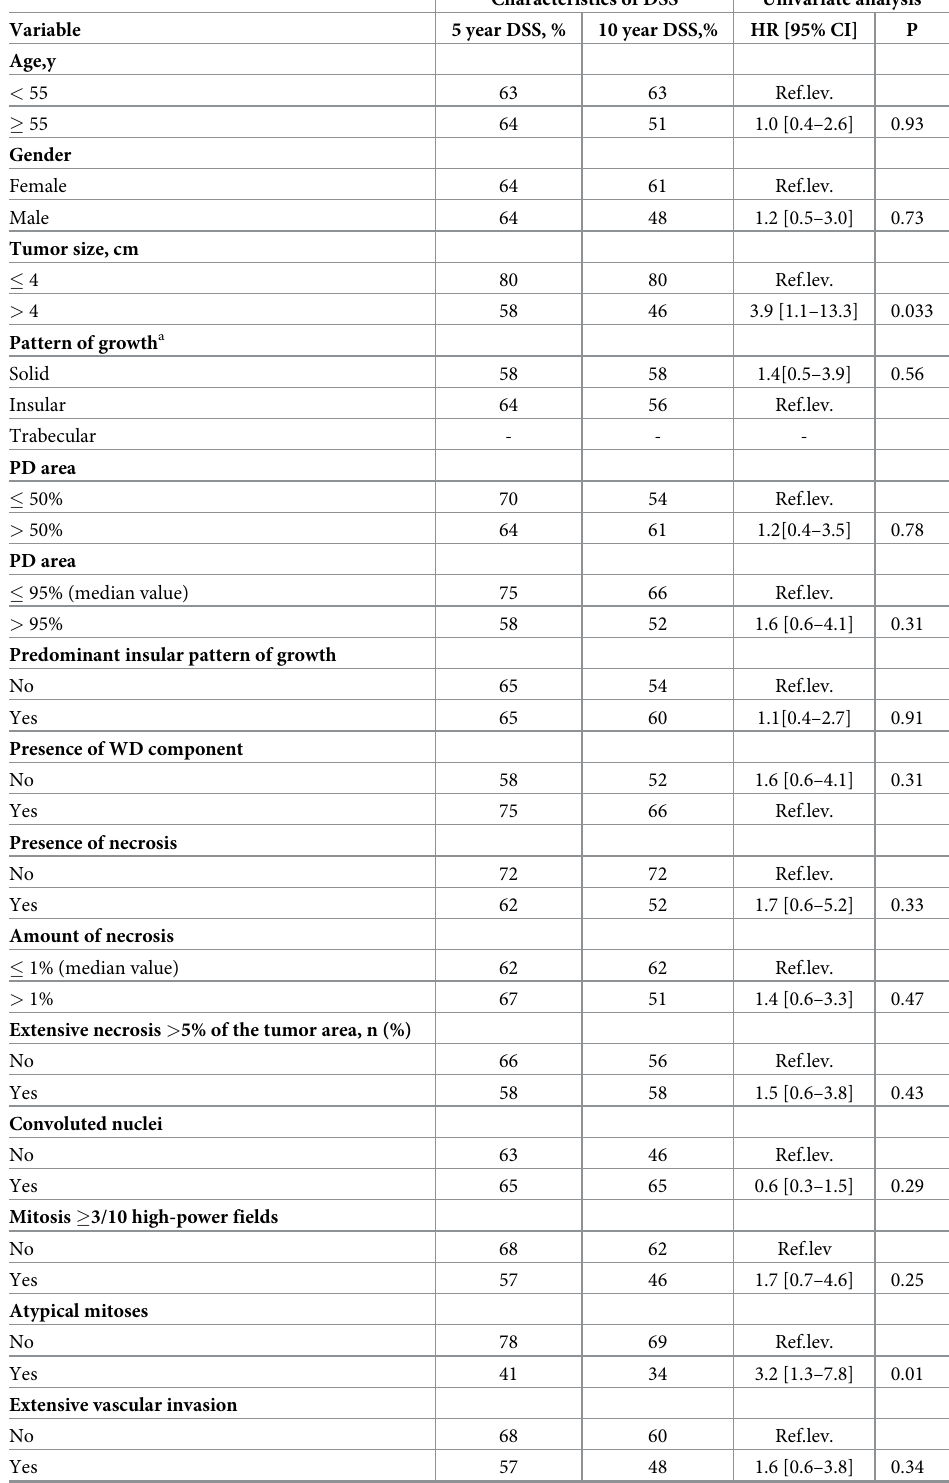
Table 3. Predictive factors of disease-specific survival in PDTC